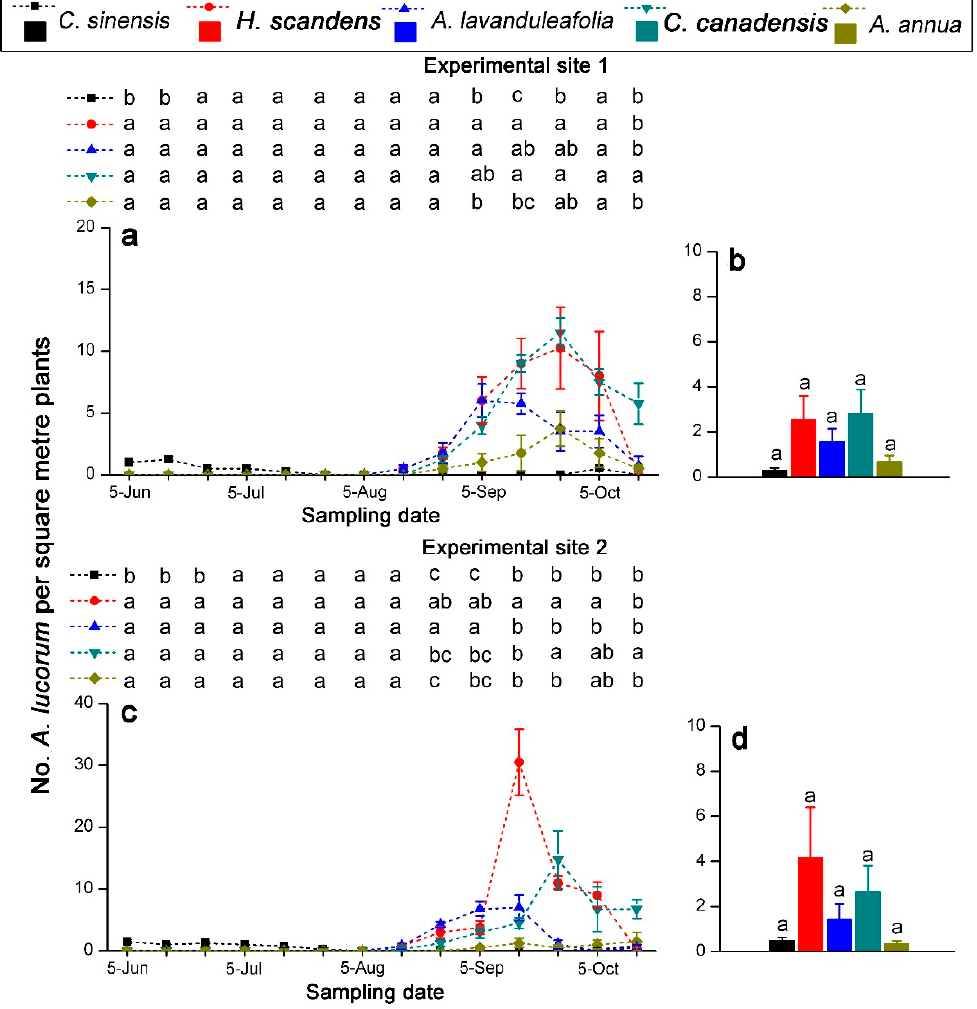
Figure 5. Seasonal changes of population density ( a and c ) and seasonal density ( b and d ) of A. lucorum on tea plants and four weed host plants in the tea agro-ecosystem in 2016. Different letters indicate significant differences among different host plants (Tukey’s HSD test, p < 0.05).